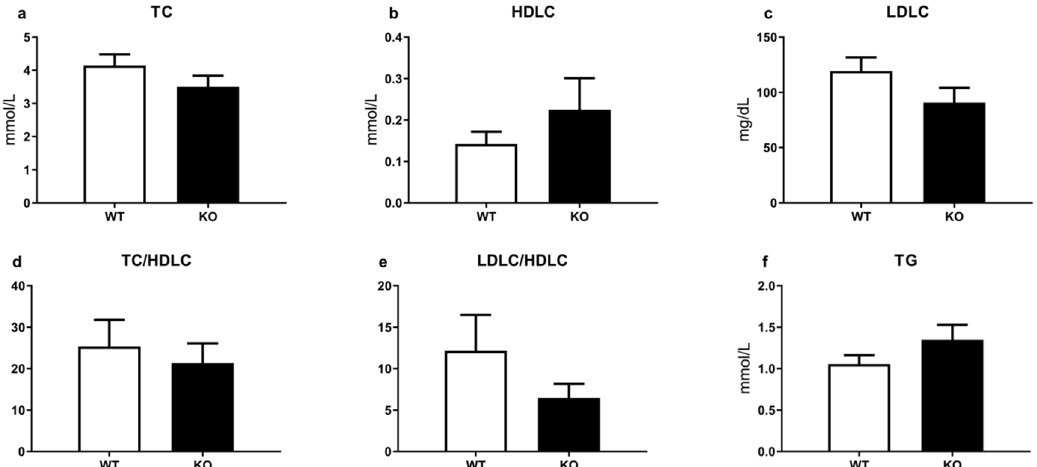
Figure 4. Comparative analysis of main lipid exchange biochemical parameters and ratios in the blood of TAAR1-KO and WT mice. ( a ) Total cholesterol (TC), ( b ) high-density lipoprotein cholesterol (HDLC), ( c ) low-density lipoprotein cholesterol (LDLC), ( d ) total cholesterol/high-density lipoprotein ratio (TC/HDLC), ( e ) ratio of low-density lipoprotein cholesterol and high-density lipoprotein cholesterol (LDLC/HDLC), ( f ) triglycerides (TG). There are only minimal alterations in all presented parameters. Data are mean ± SEM.